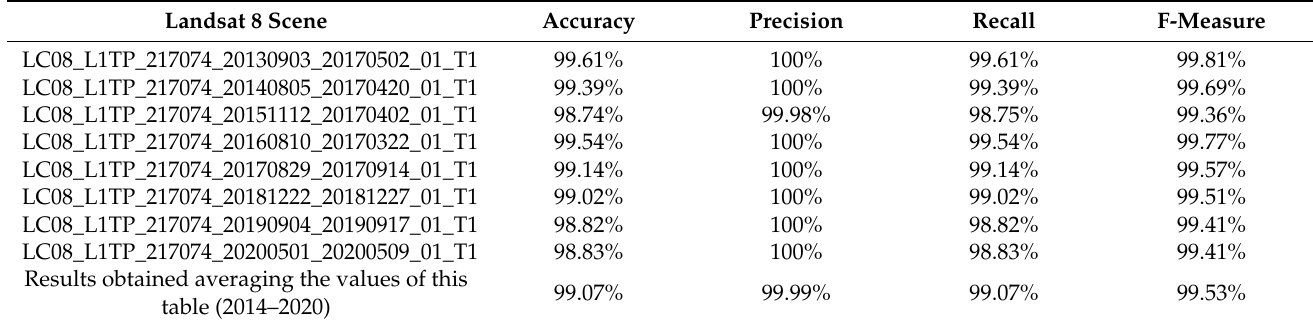
Table 13. Accuracy, precision, recall, and F-measure of the proposed strategy for different Landsat 8 images. These metrics were calculated based on Equations (24)–(27) and the information presented in Tables 5–12, respectively.